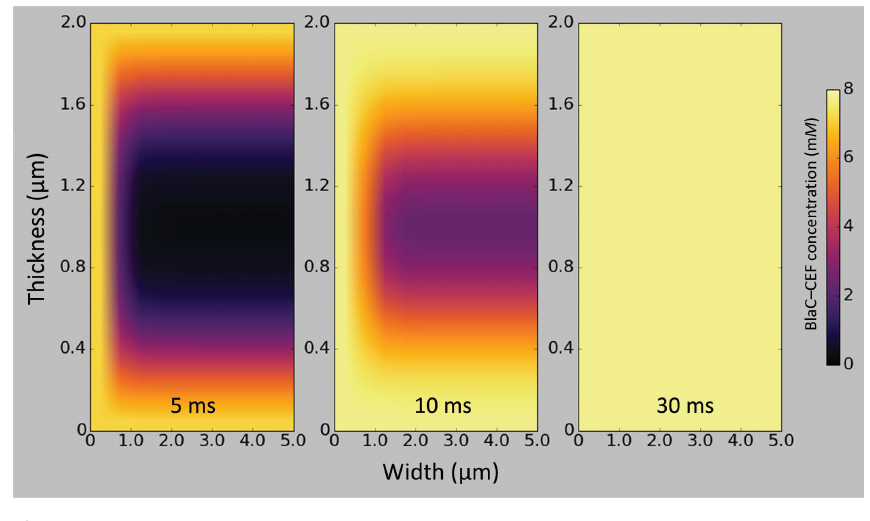
Figure 8 Concentrations of the BlaC–CEF complex in 10 (cid:3) 10 (cid:3) 2 m m platelet-shaped crystals ( a ) 5 ms, ( b ) 10 ms and ( c ) 30 ms after mixing with 200 m M ceftriaxone (150 m M final concentration assumed). The concentrations are shown in different colors (see the scale bar on the right) in central cross sections through half the width of the crystals. The drawings are not to scale, since the sections displayed are 5 m m horizontally (width) and 2 m m vertically (thickness). The enlargement along the short 2 m m axis allows the display of the nuanced occupancy differences.